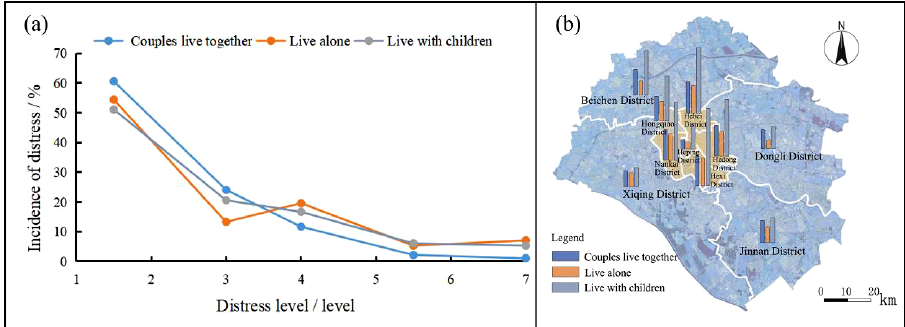
Figure 8. Family status differences and spatial characteristics of distress: a) Distribution of distress influence levels of different family statuses; b) Map of family status difference in emotional health risks of